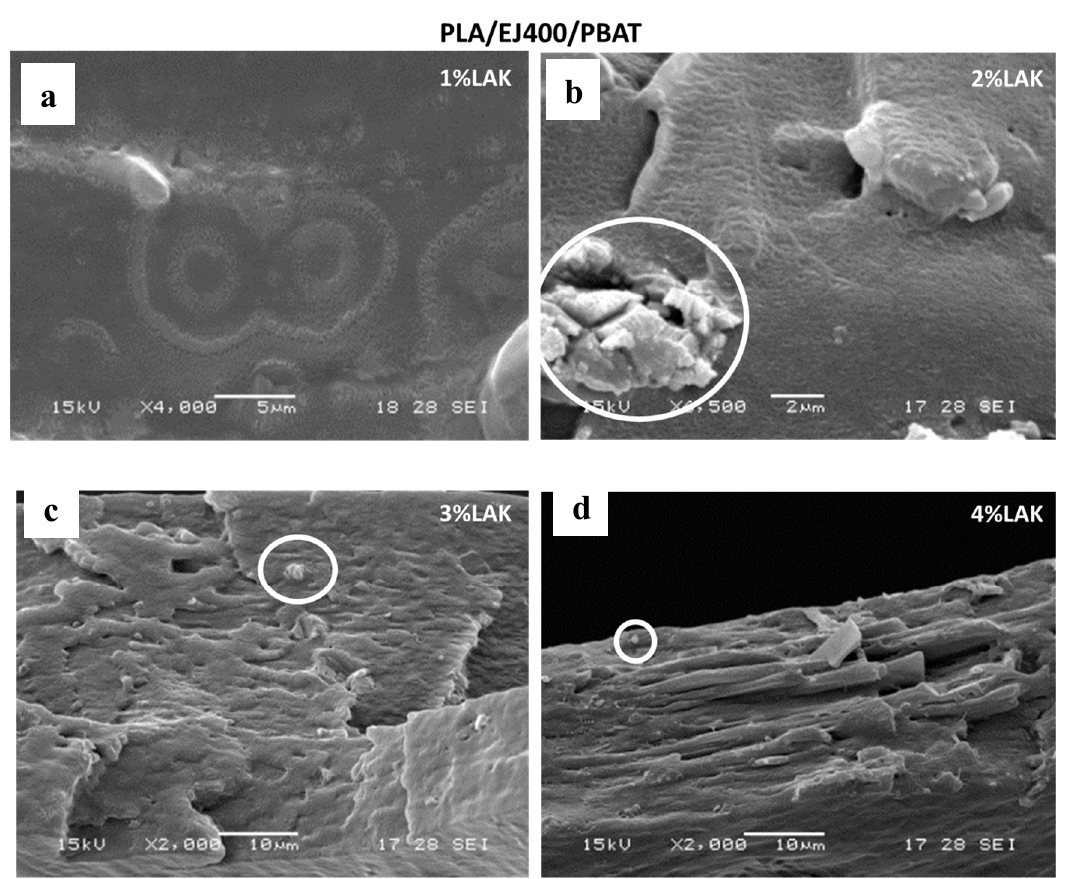
Figure 6. SEM micrographs of cryogenic fractures films based on PLA/EJ400/PBAT containing different amount of LAK: ( a ) 1% LAK; ( b ) 2% LAK; ( c ) 3% LAK; ( d ) 4% LAK.